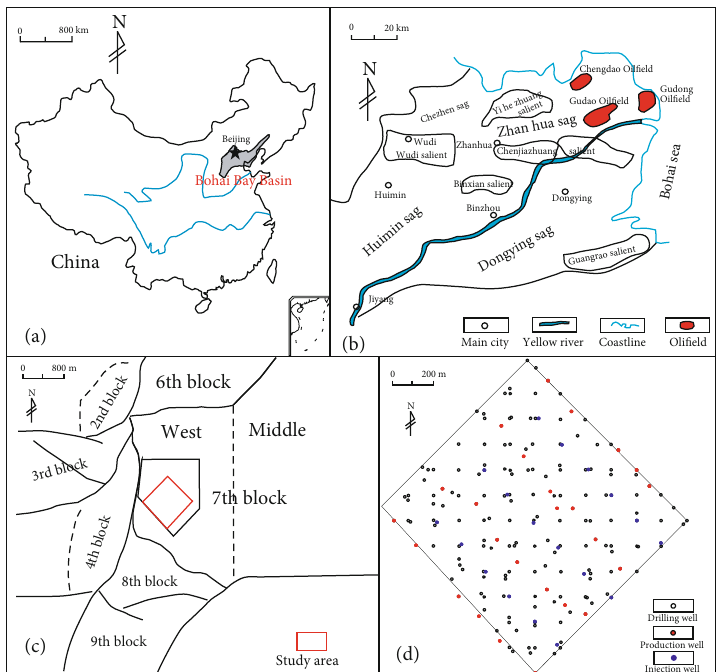
Figure 1: (a) Bohai Bay Basin. (b) Jiyang Depression. (c) Gudong oil fi eld and the location of the study area. (d) The distribution of wells in the study area.